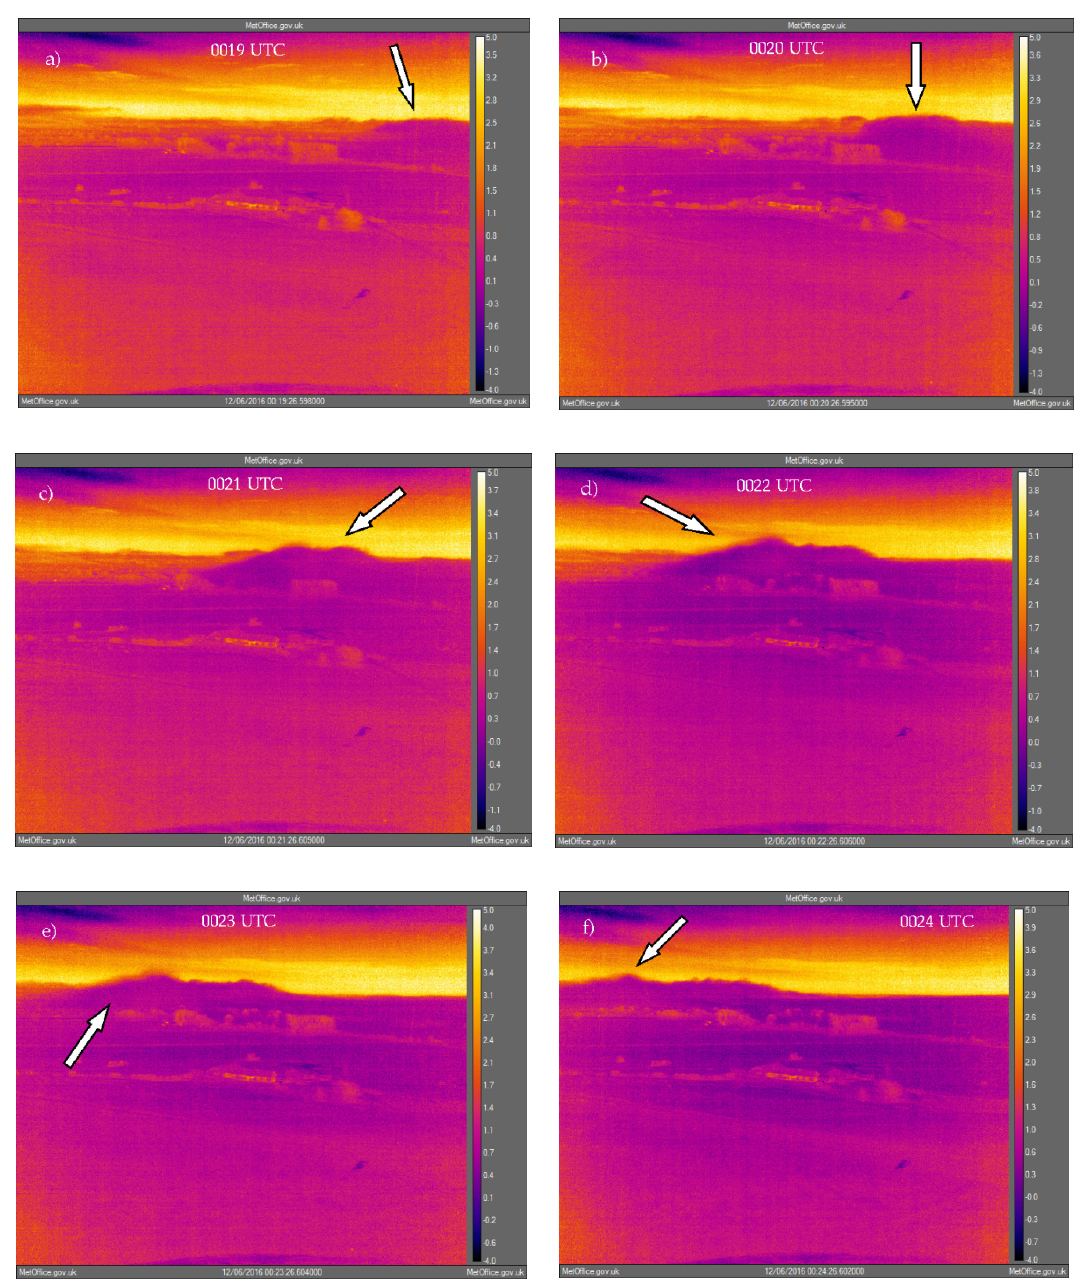
Figure 8. IR imagery illustrating the passage of a gravity current over Cardington on 6 December 2016 at ( a ) 0019 UTC, ( b ) 0020 UTC, ( c ) 0021 UTC, ( d ) 0022 UTC, ( e ) 0023 UTC and ( f ) 0024 UTC. Arrows indicate the front of the current.